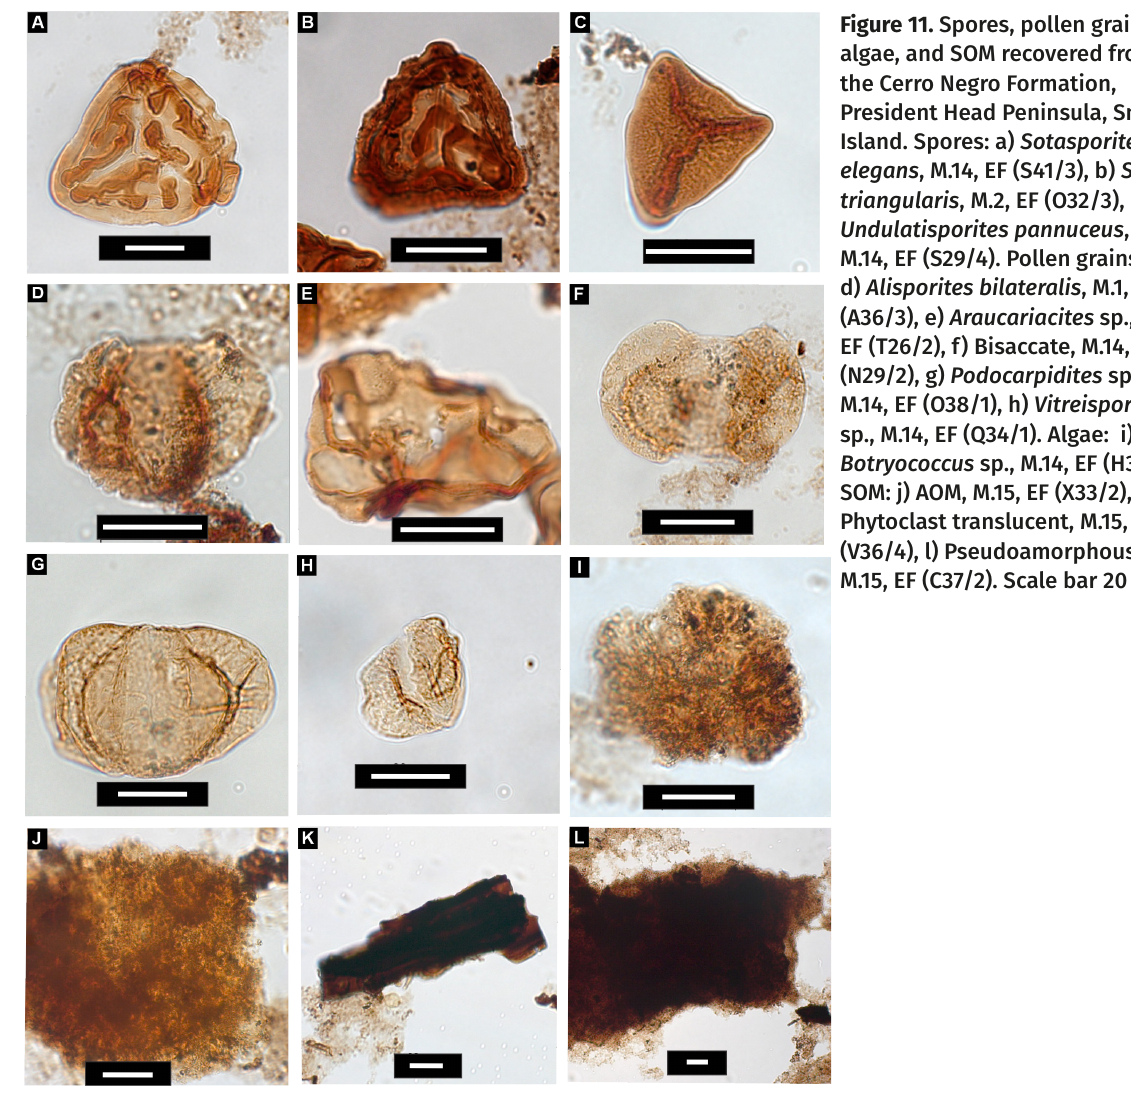
Figure 11. Spores, pollen grains, algae, and SOM recovered from the Cerro Negro Formation, President Head Peninsula, Snow Island. Spores: a) Sotasporites elegans , M.14, EF (S41/3), b)